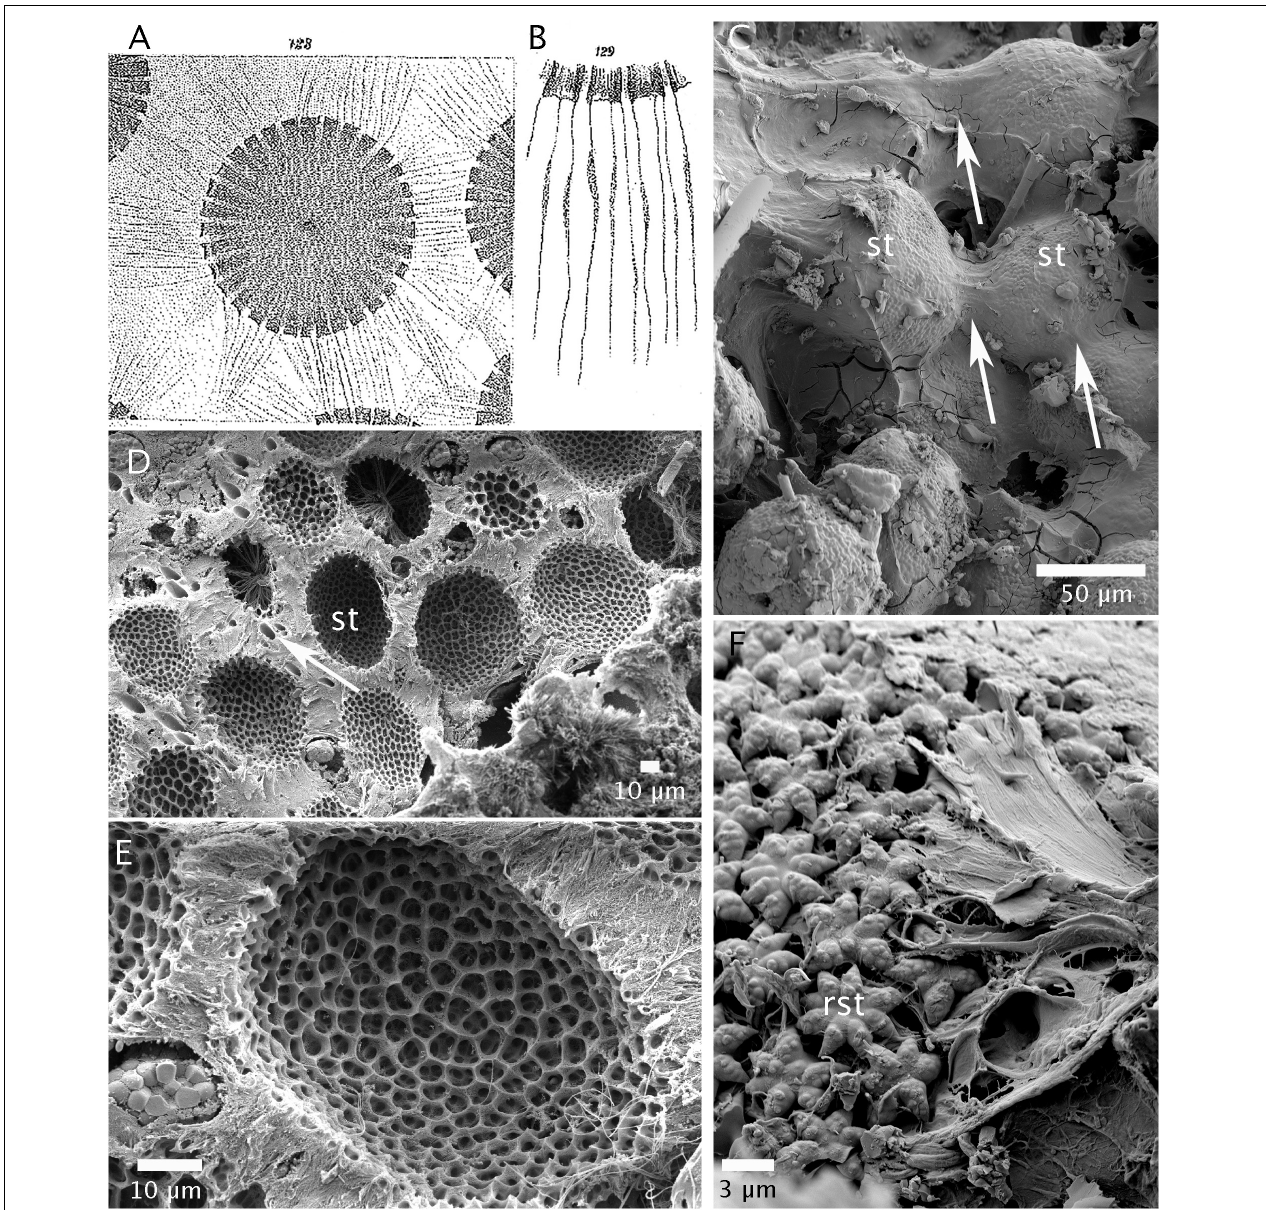
FIGURE 1 | Position of sterrasters in the cortex. (A) Sterrasters in the endocortex of Geodia cydonium , connected via fibers, drawing is a copy from von Lendenfeld, (1894, plate VIII, 128). A sterraster in this species is 70 µ m in diameter. (B) Possible fibrous cells attached to sterraster rosettes, drawing is a copy from von Lendenfeld, (1894, plate VIII, 129). A rosette is 5 µ m in diameter. (C) Freeze-dried cortex of Geodia barretti showing fiber bundles (arrows) connecting the sterrasters (st). Scale: 50 µ m. (D) Cryofracture in the cortex of G. barretti with spicules dissolved beforehand. Pockets in which sterrasters (st) are positioned in the endocortex, surrounded by a dense collagen-type matrix. Other holes (white arrow) indicate the position of the microxeas crossing the cortex. Scale: 10 µ m. Picture: V. Koutsouveli and A. Riesgo. (E) Sterraster mold showing that every rosette is tightly inserted in a pocket, in the matrix. A spherulous cell is visible on the left (just above the scale). Same specimen as in D. Scale: 10 µ m. Picture: V. Koutsouveli and A. Riesgo. (F) Close-up of a sterraster showing fibrils attached to the warty rosettes (rst), Same specimen as in C. Scale: 3 µ